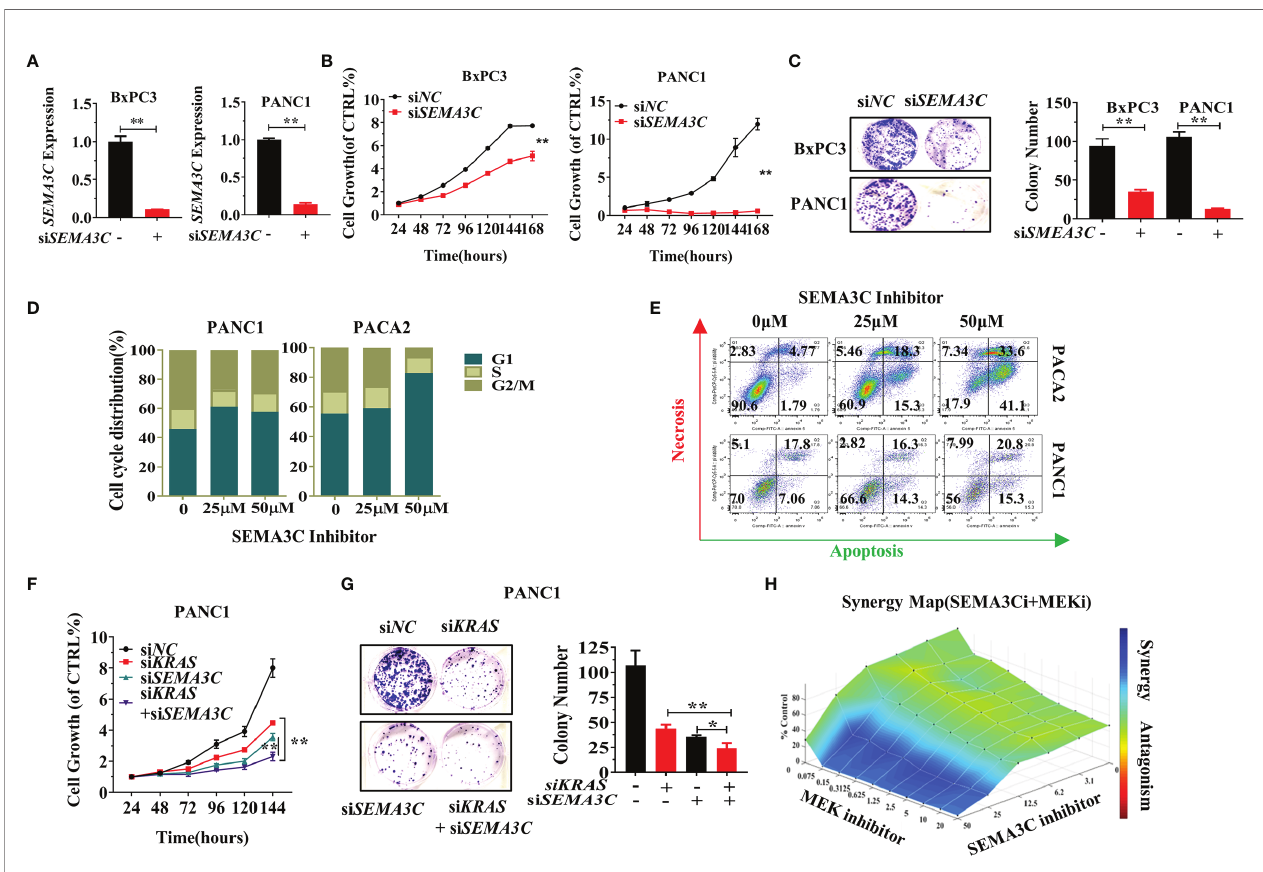
FIGURE 3 | (A) Expression levels of SEMA3C detected by qPCR after treatment with siSEMA3C . (B) The cell growth of pancreatic cells evaluated by the CellTiter- Glo ® 2.0 assay. (C) Colony formation assays were assessed after the knockdown of the SEMA3C expression in pancreatic cancer cells. (D) Cell cycle evaluation in pancreatic cancer cells after treatment of SEMA3C inhibitor 24 hours. (E) Cell necrosis and apoptosis evaluation in pancreatic cancer cells after treatment of SEMA3C inhibitor 24 hours. (F, G) The synergistic effect of the si KRAS and si SEMA3C in cell growth and cell colony formation assessed after knocking down the expression of KRAS, SEMA3C, or both in PANC1 cells. (H) Synergistic effects on cell viability evaluated by combining trametinib and SEMA3C inhibitor in KPC cells calculated with combene fi t software (43). Data are representative of three independent experiments. T-tests for the measurements between the two groups; *P < 0.05, **P <